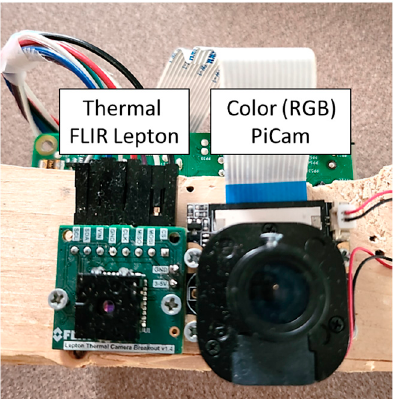
Figure 1. The RGB-T Raspberry Pi imaging system that was used for data acquisition.